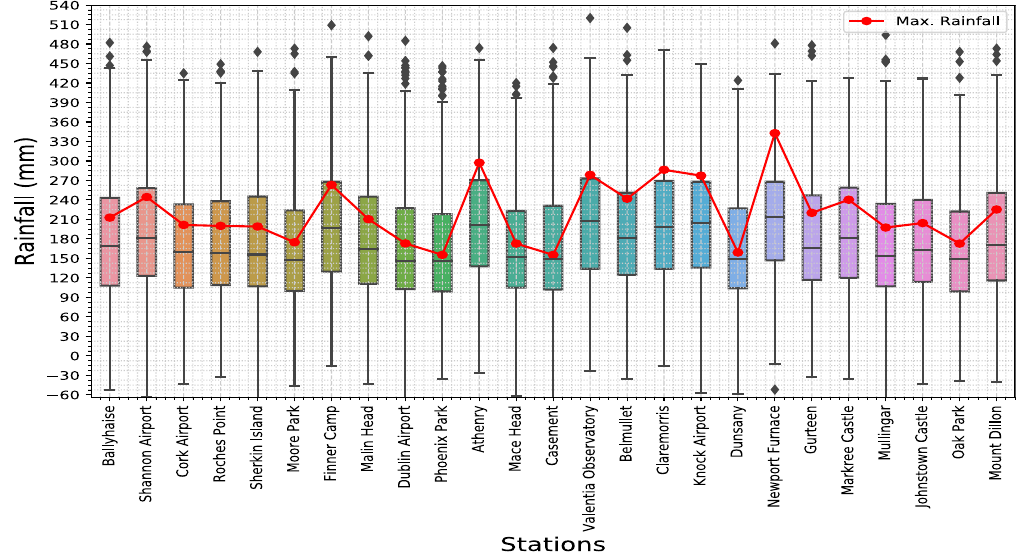
Figure 4: The maximum monthly rainfall amounts ( measured in millimeter ( mm )) for each station vs the predicted values represented by 95% prediction intervals for return period 50 years.